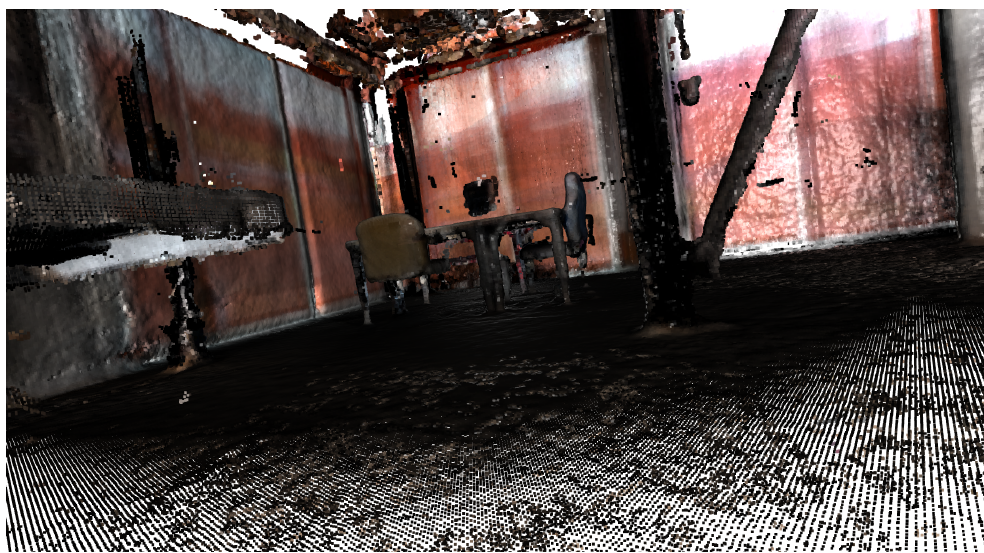
Figure 2. Visualization of a point cloud of a room.